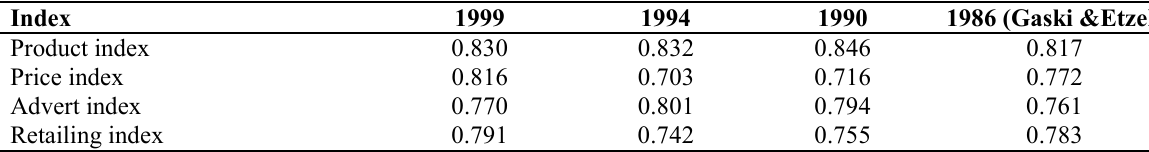
Table 3: Comparative reliability